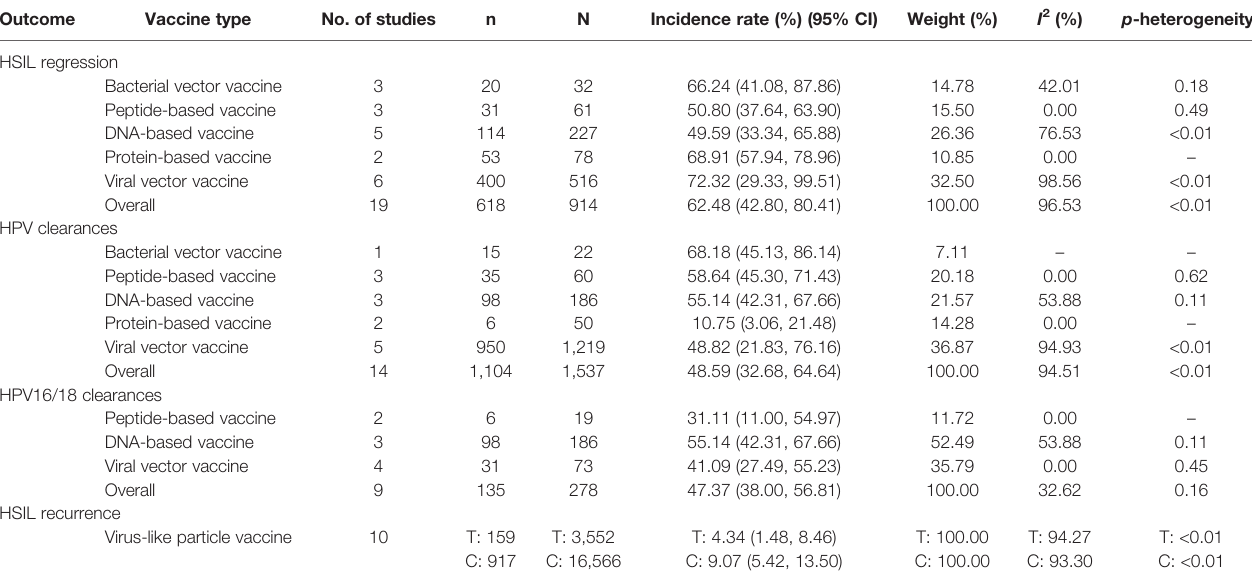
Virus-like particle vaccine